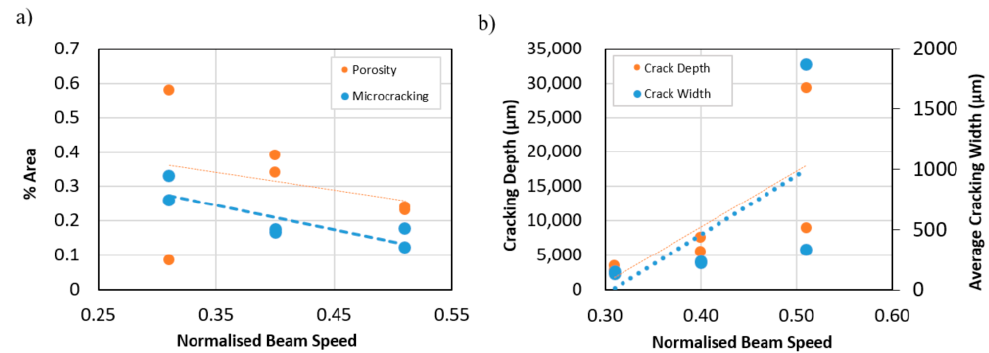
Figure 5. Influence of normalised beam speed on ( a ) microcracking and porosity in the as-built (AB) condition and ( b ) cracking post H. condition and ( b ) cracking post H.